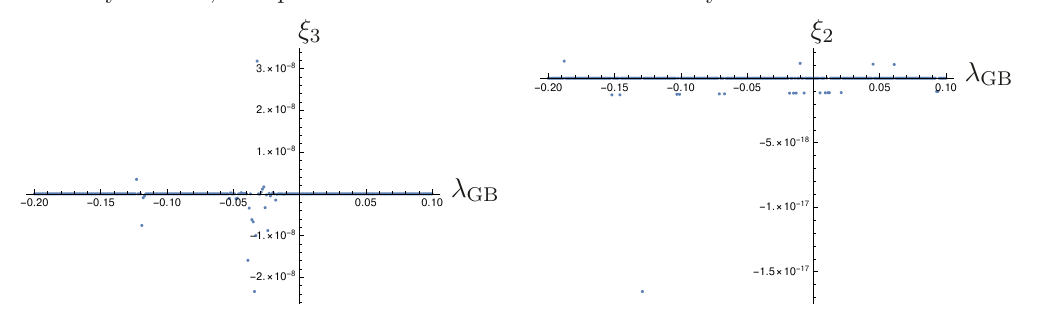
+( c 2 s 1 / 3) and so, within ∆ F ∝ −